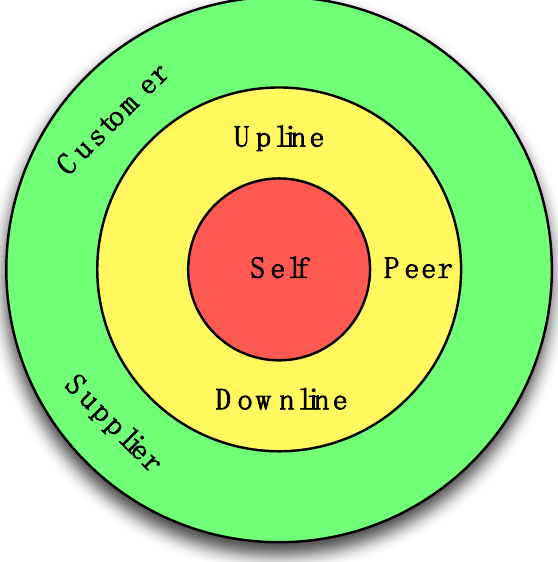
Figure 1. A model of feedback that raters used in a 360° performance.